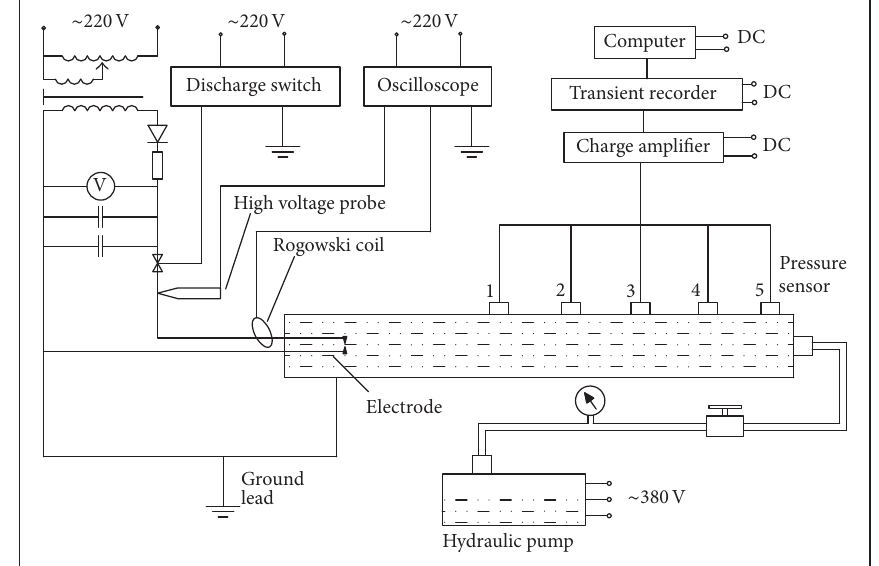
Figure 5: Experimental platform (the first part of the